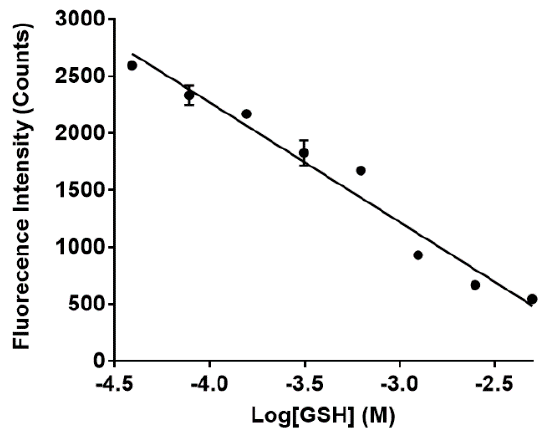
Figure 6. Fluorescence of sensor 1 (final concentration 50 μ M) in the presence of GSH. Maximum fluorescence intensities of 1 ( λ em = 650 nm) in the presence of increasing concentration (0–5 mM) of GSH was plotted against the log of GSH concentrations in M.